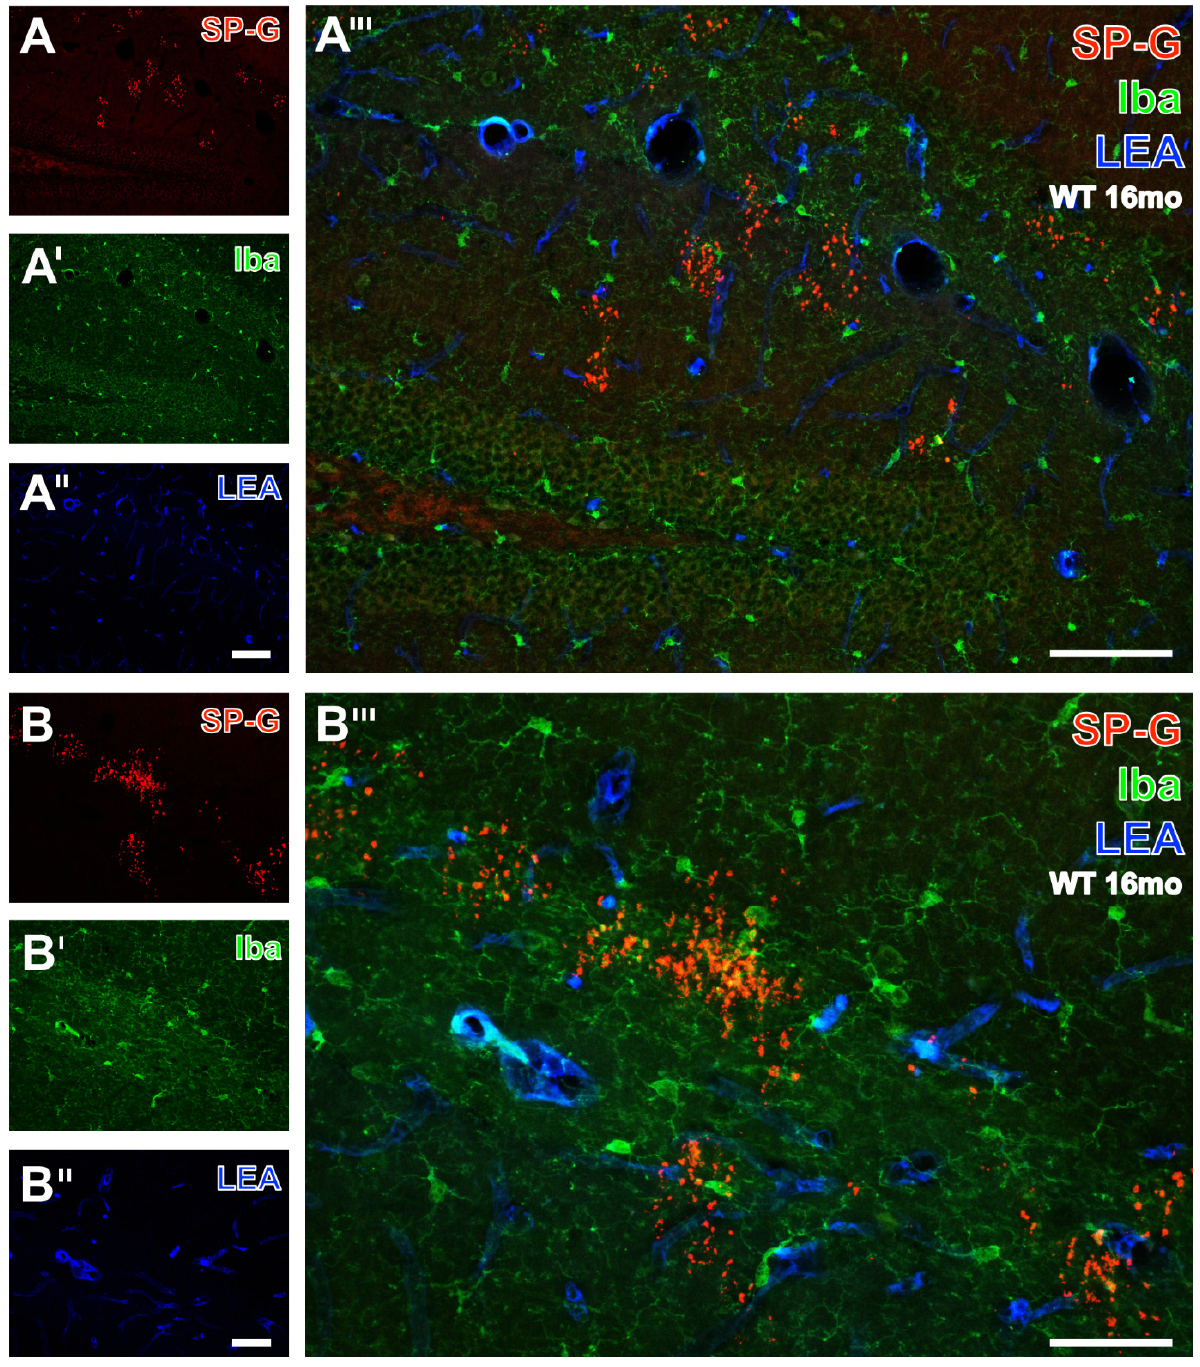
Figure 5. Simultaneous fluorescence labeling of SP-G, LEA-positive vessels, and microglial Iba in the hippocampus of a 16 month-old WT mouse. At a lower magnification, SP-G-ir ( A ) is largely restricted to several clusters of dots in the stratum lacunosum-moleculare of the CA1 field and the molecular layer of the dentate gyrus. In parallel, Iba-immunopositive microglia ( A’ ) are evenly dis- tributed in the presented gyrus dentatus and stratum lacunosum-moleculare. Additional vascular